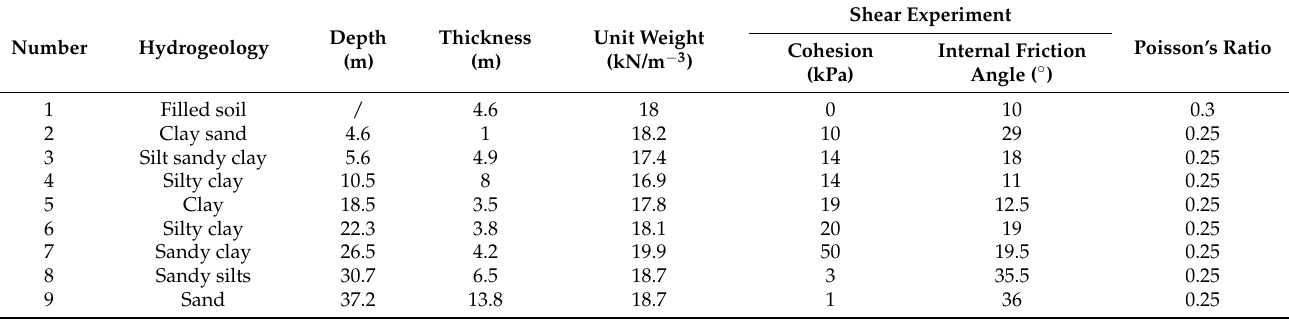
Table 1. Mechanical parameters of soil.